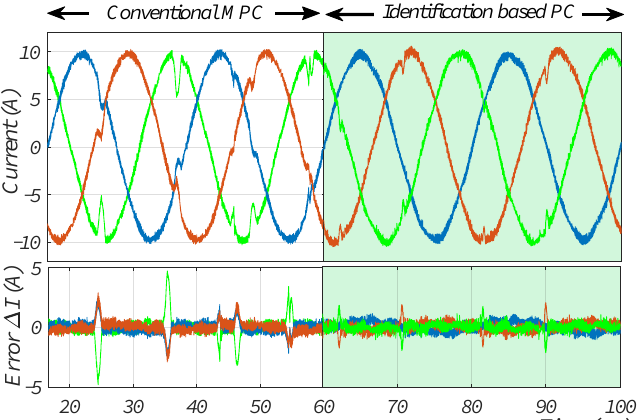
Figure 7. Impact of parameter mismatch on steady state output current of VSC: Double specified resistive load ( R × 2) and one half of filter inductance ( L